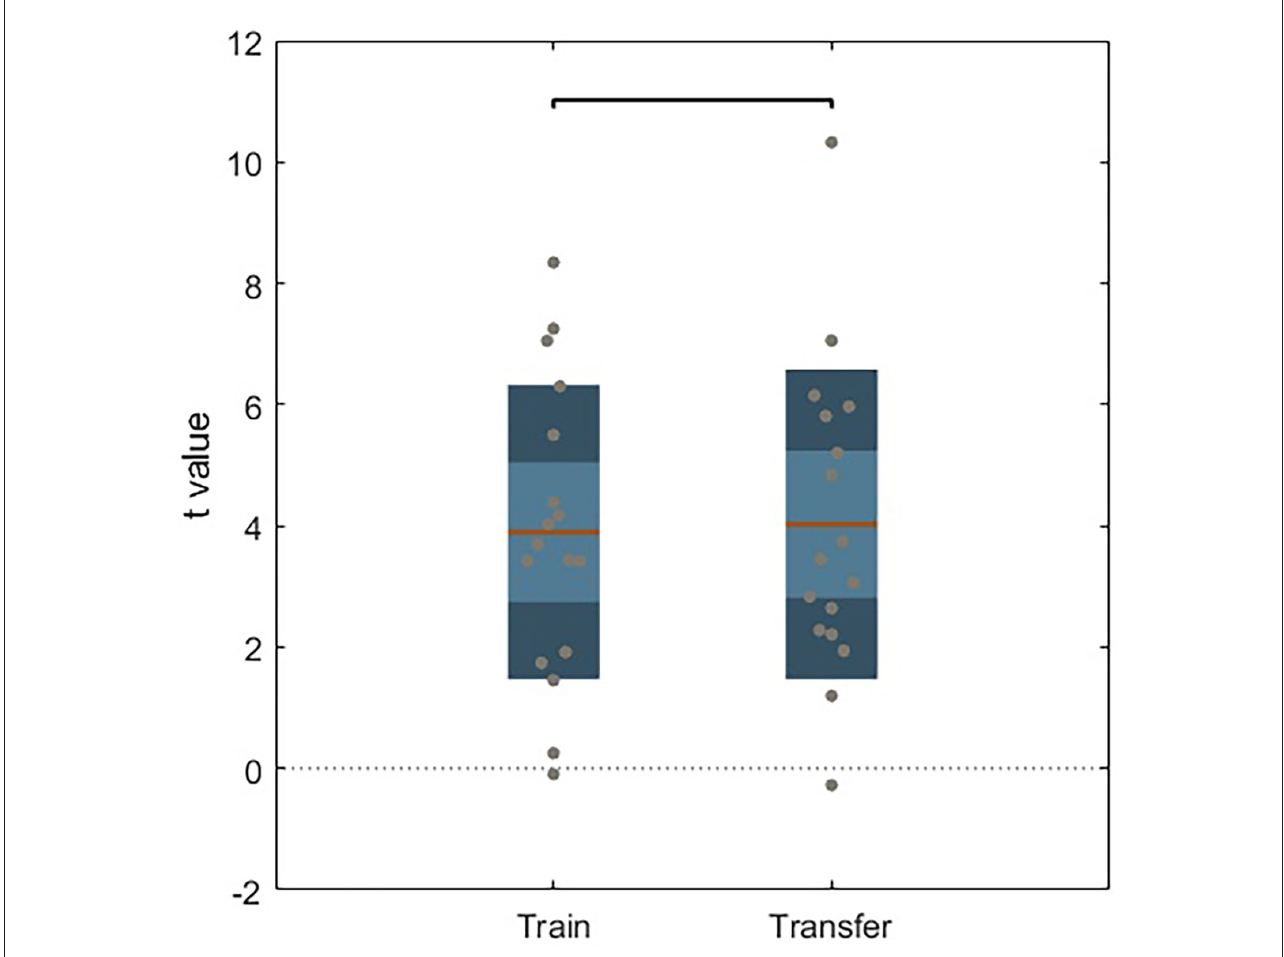
FIGURE4 Unpaired t -test between train and transfer for active NF group. Dark color areas represent one standard deviation, light color areas represent the 95% confidence interval for the mean. Gray dots represent data for each subject. The brown line is the mean for each group.